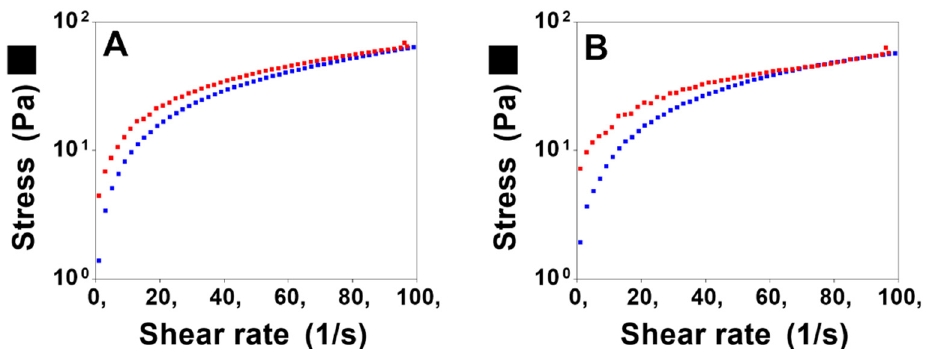
Figure 5. Flow rheograms: HG ( A ) and HG@MSN-CCM ( B ). Red symbol represents the upward curve and blue symbol represents the down curve. Analysis performed at 32 °C. Table 2. Flow behavior ( n ) and consistency index (K) of the hydrogels .